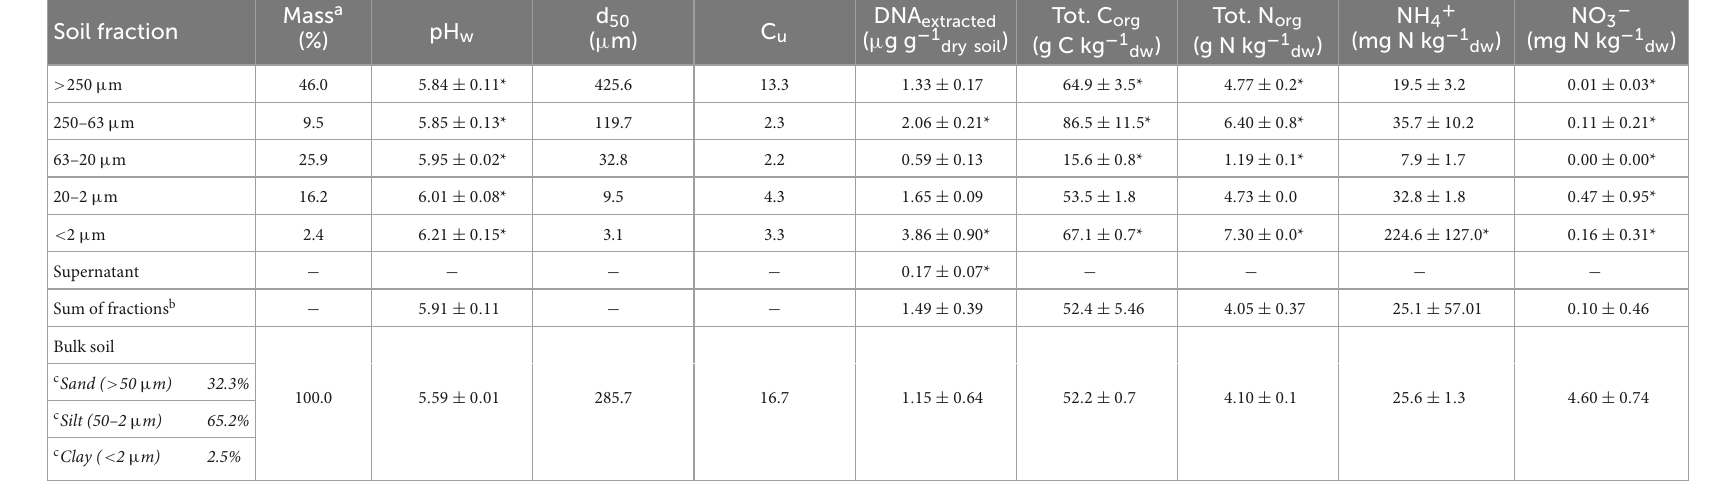
a Gravimetricportionoffractiontobulksoil. b Sumofallfractions( > 250,250–63,63–20,20–2, < 2 µ m,andsupernatant)accordingtotheirmasscontributionofbulksoil(a). c Textureestimatedbysizedistributioncurvesofbulksoilsampleswithappliedultrasonication. d 50 ,sizewhichsplitsthetotalvolumesofparticlesdetectedinthedistributionbyhalf(see SupplementaryFigure1 ). C u ,coefficientofuniformity–d 60 /d 10 ;pH W ,measuredafterfractionationwithdistilledwater.